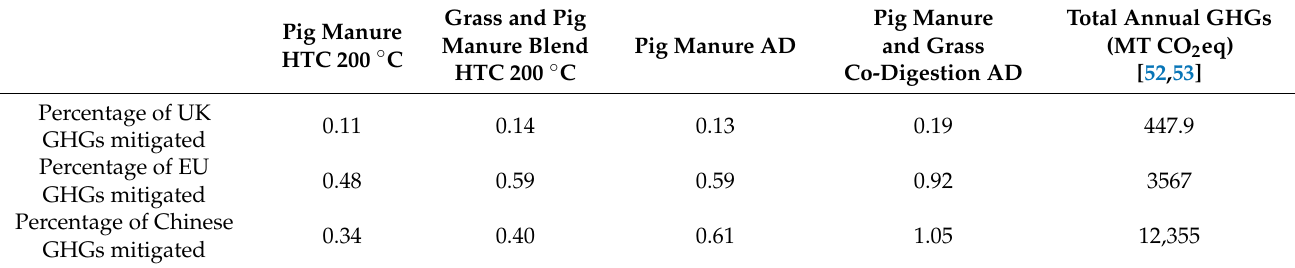
Table 10. Total and proportional GHG mitigation from PM and grass HTC, and in the UK, the EU, and